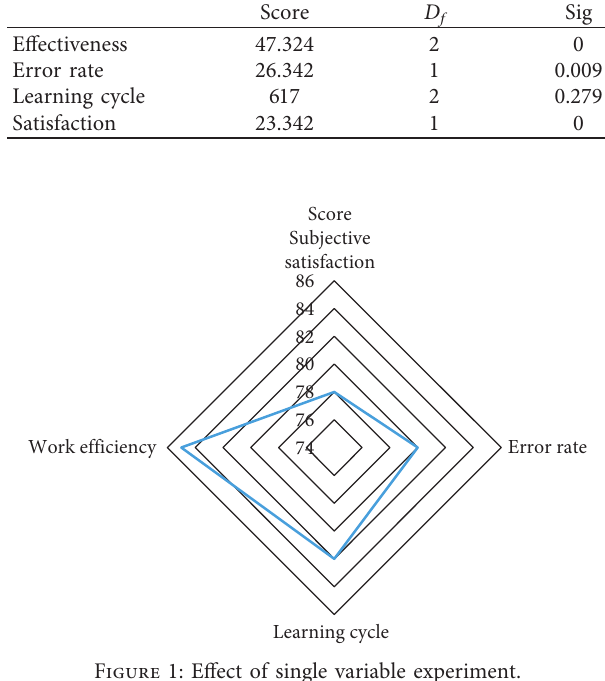
Figure 1: Effect of single variable